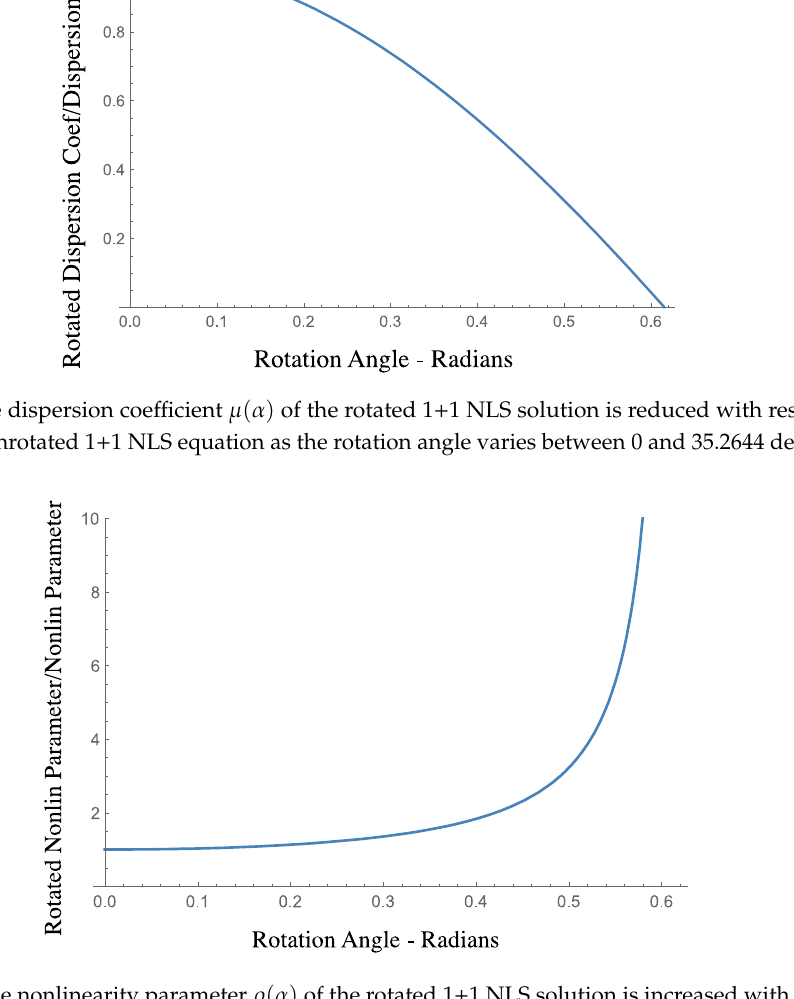
Figure 10. The nonlinearity parameter ρ ( α ) of the rotated 1 + 1 NLS solution is increased with respect Figure 10. The nonlinearity parameter  (  ) of the rotated 1+1 NLS solution is increased with Figure 10. The nonlinearity parameter  (  ) of the rotated 1+1 NLS solution is increased with Figure 10. The nonlinearity parameter  (  ) of the rotated 1+1 NLS solution is increased with to that for the unrotated. 1 + 1 NLS equation as the rotation angle varies between 0 and 35.2644 respect to that for the unrotated. 1+1 NLS equation as the rotation angle varies between 0 and 35.2644 respect to that for the unrotated. 1+1 NLS equation as the rotation angle varies between 0 and 35.2644 respect to that for the unrotated. 1+1 NLS equation as the rotation angle varies between 0 and 35.2644 degrees. degrees. degrees.